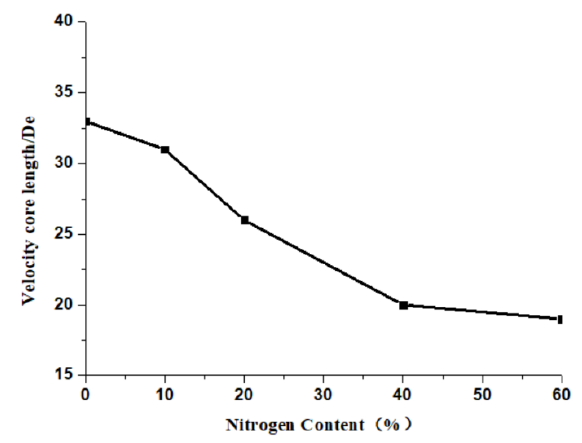
Figure 6. Velocity core length for various jets.